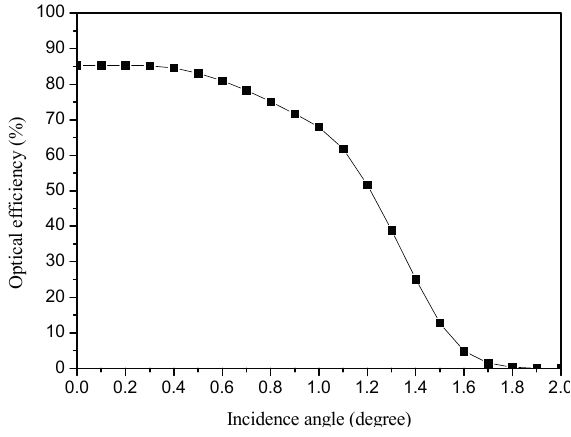
Figure 6. Optical efficiency of the Fresnel lens with KFTS-type